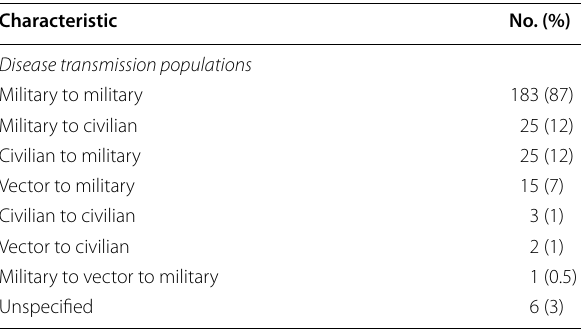
Table 1 Summary of selected characteristics of the 210